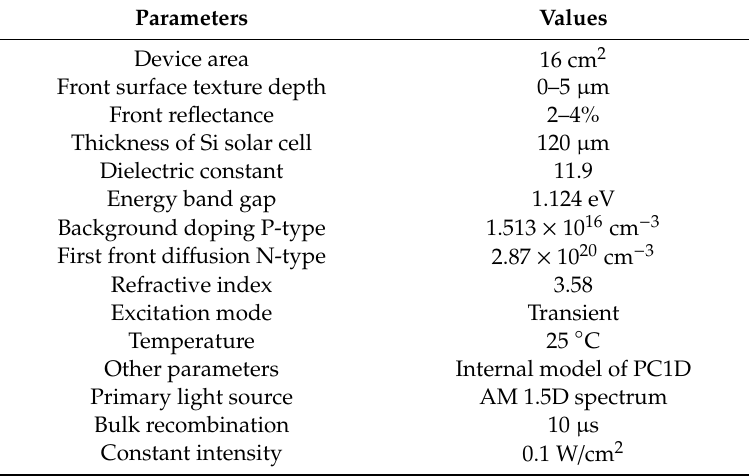
Table 1. Primary parameters used in the PC1D